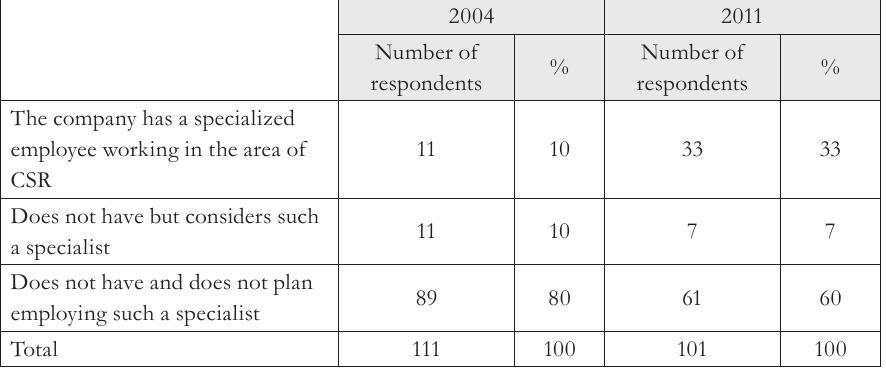
Tab.7 - A specialized employee working in the area of CSR. Sources: Trnková (2004), own